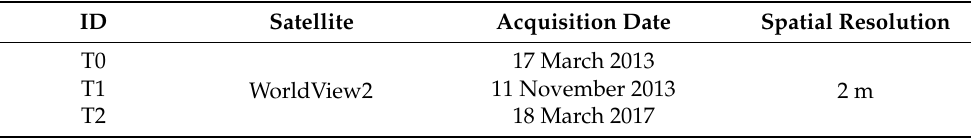
Table 1. Remote sensing images used in this